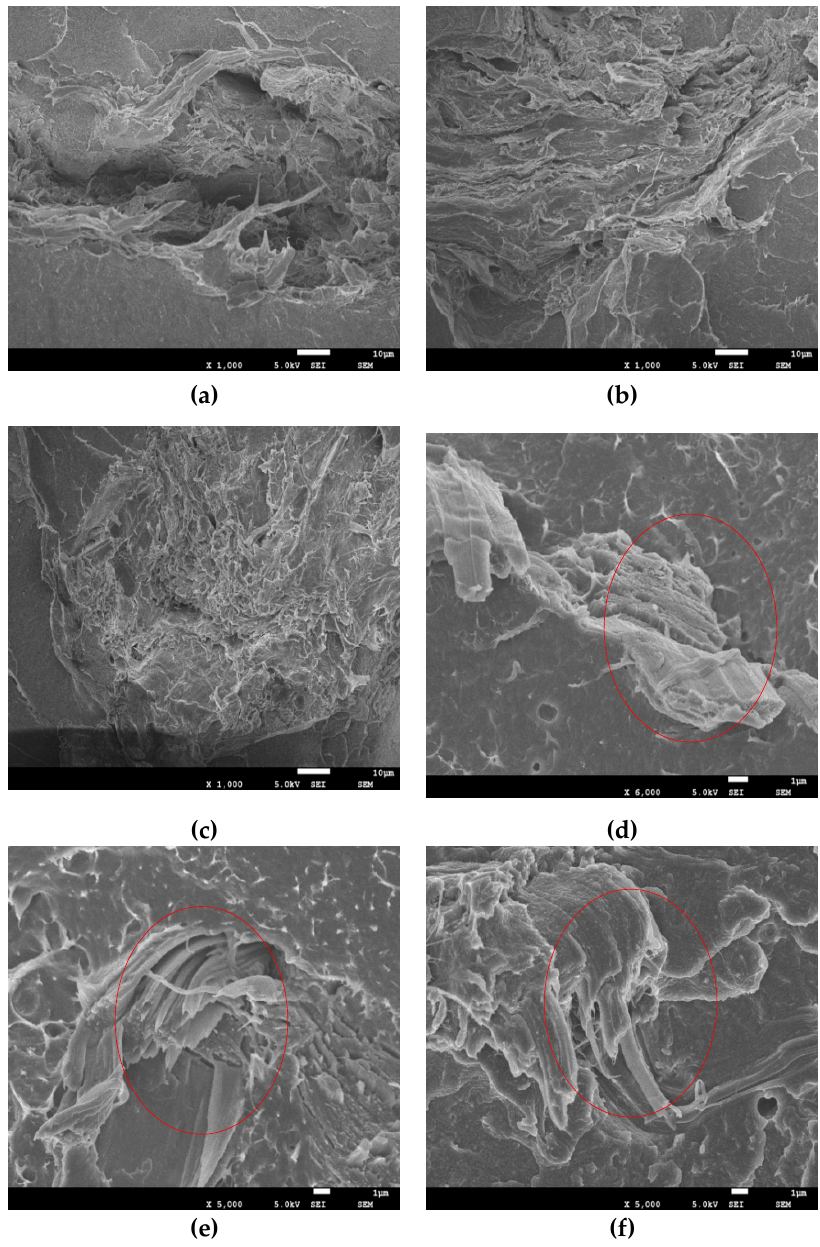
Figure 8. SEM images of untreated MFC/LLDPE and STMFC/LLDPE composites. Untreated MFC: ( a ) 4 wt%, ( b ) 10 wt% and ( c ) 14 wt%. STMFC: ( d ) 4 wt%, ( e ) 10 wt% and ( f ) 14 wt%.